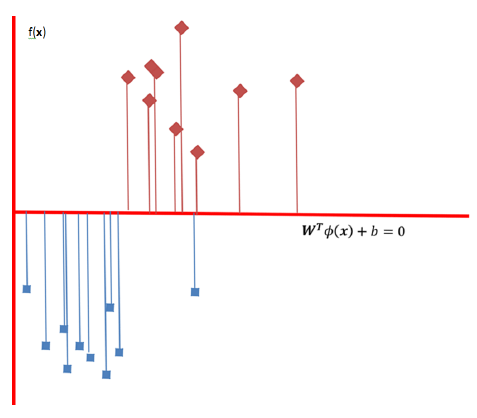
Figure 5: f ( x ) of test samples from decision boundary confidence measure. The decision function outputs the class label which input vector x belongs to (Chang and Lin, 2011).